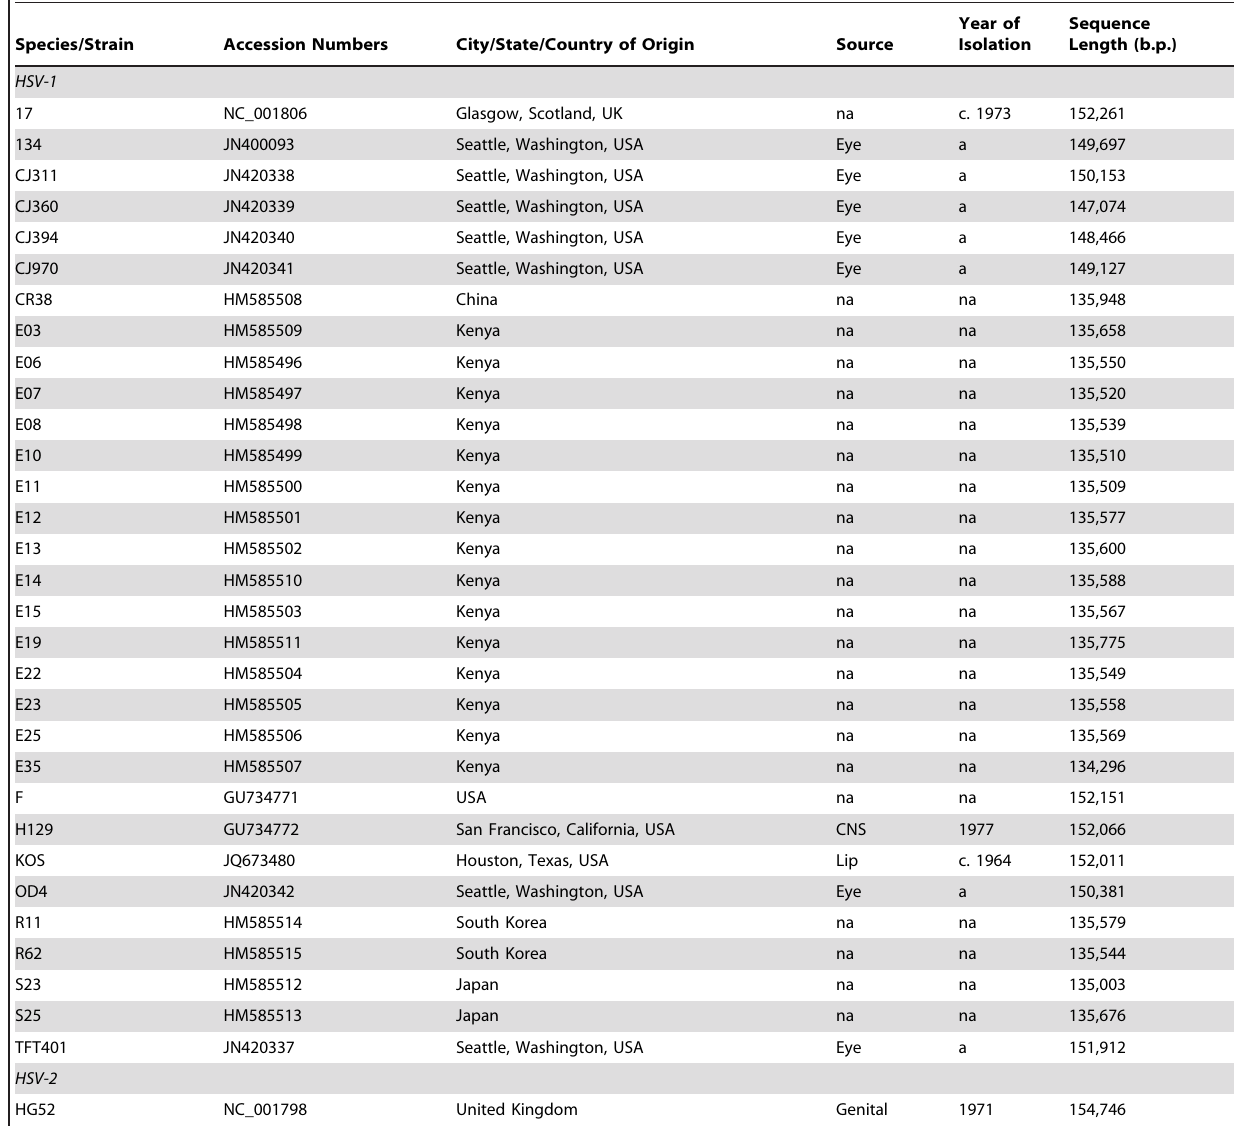
Table 1. Genomes and accession